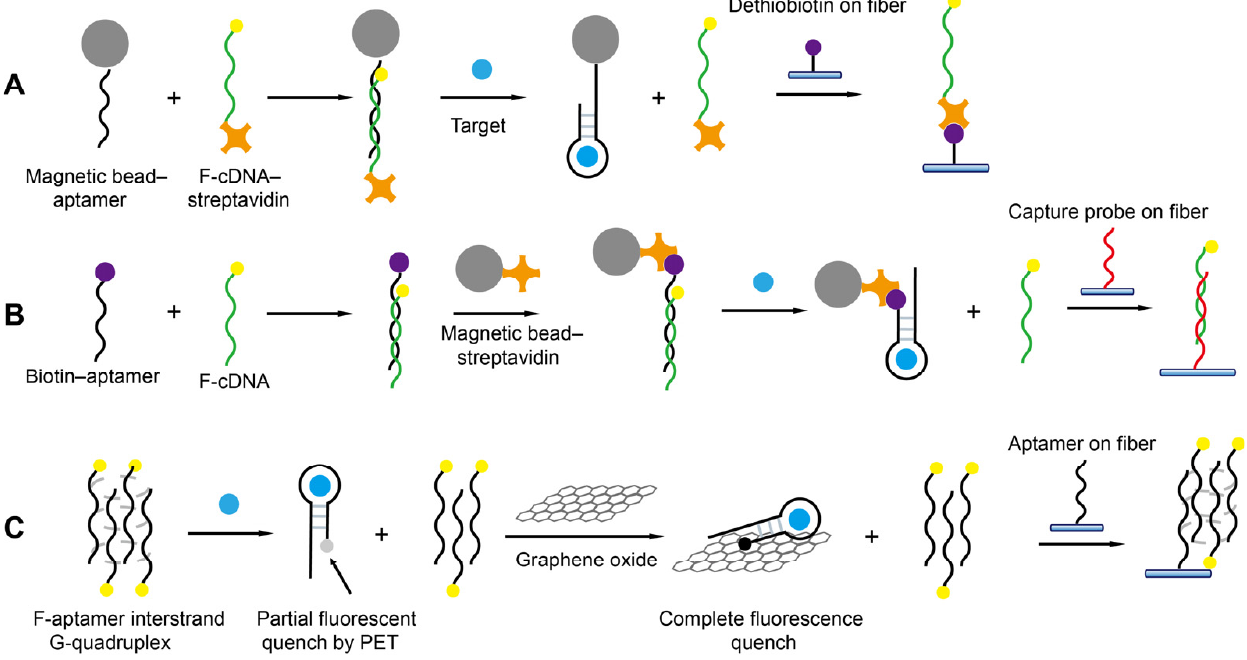
Figure 12. The o ffl ine-separation-based detection of small-molecule targets using FOEW sensors Figure 12. The offline-separation-based detection of small-molecule targets using FOEW installed with fi bers functionalized by ( A ) dethiobiotin [66] ; ( B ) capture probe complementary to cDNA of aptamer [74] ; and ( C ) aptamer [78] .